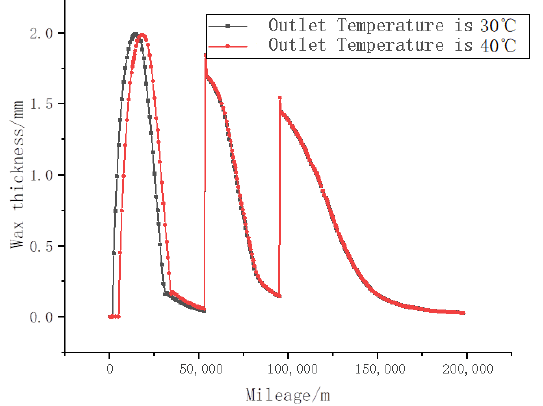
Figure 5. Wax deposition thickness at different outlet temperatures.